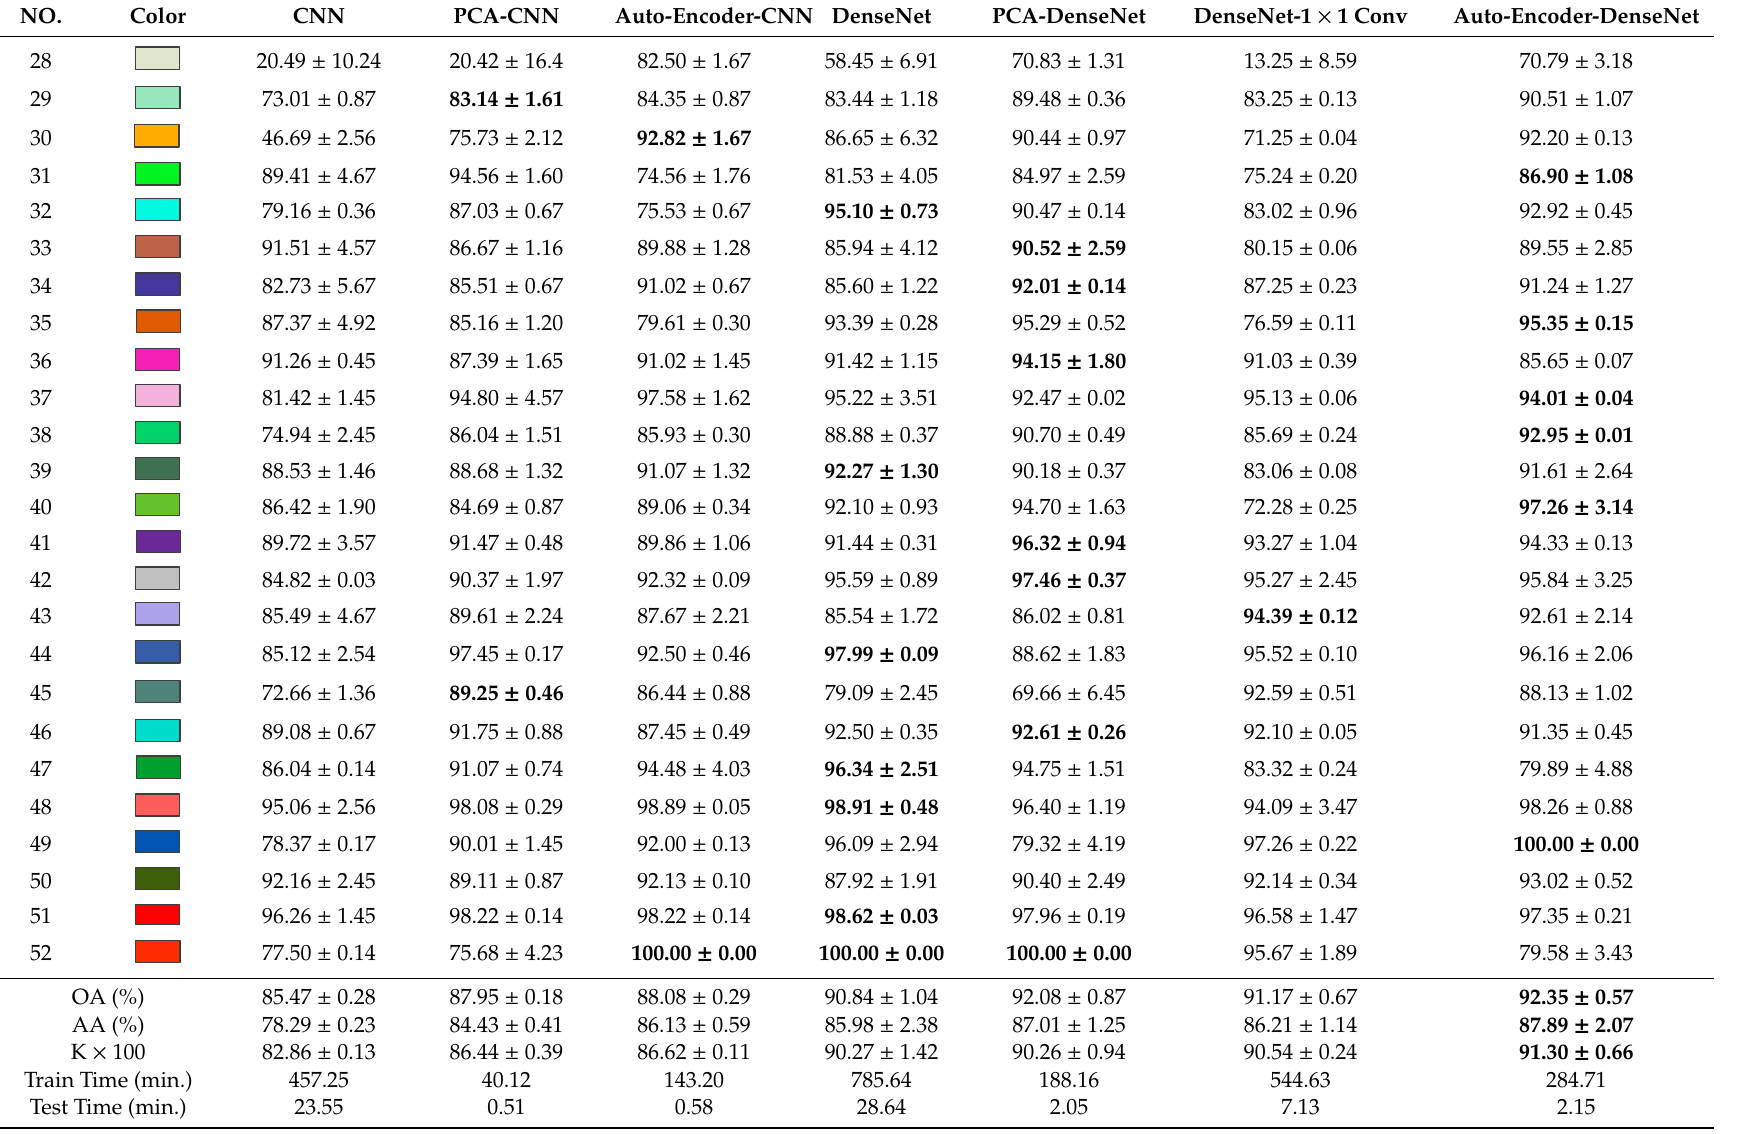
Table 2. The detailed framework of DenseNet.